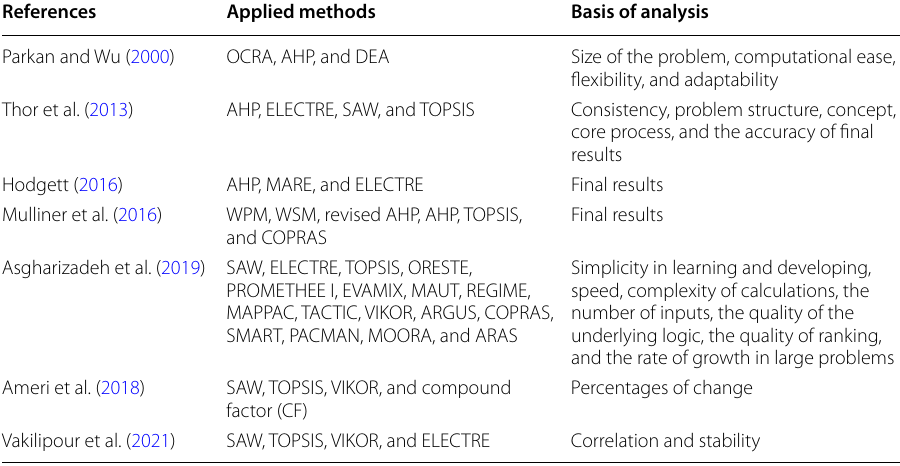
Table 1 Summary of relevant studies on MCDM